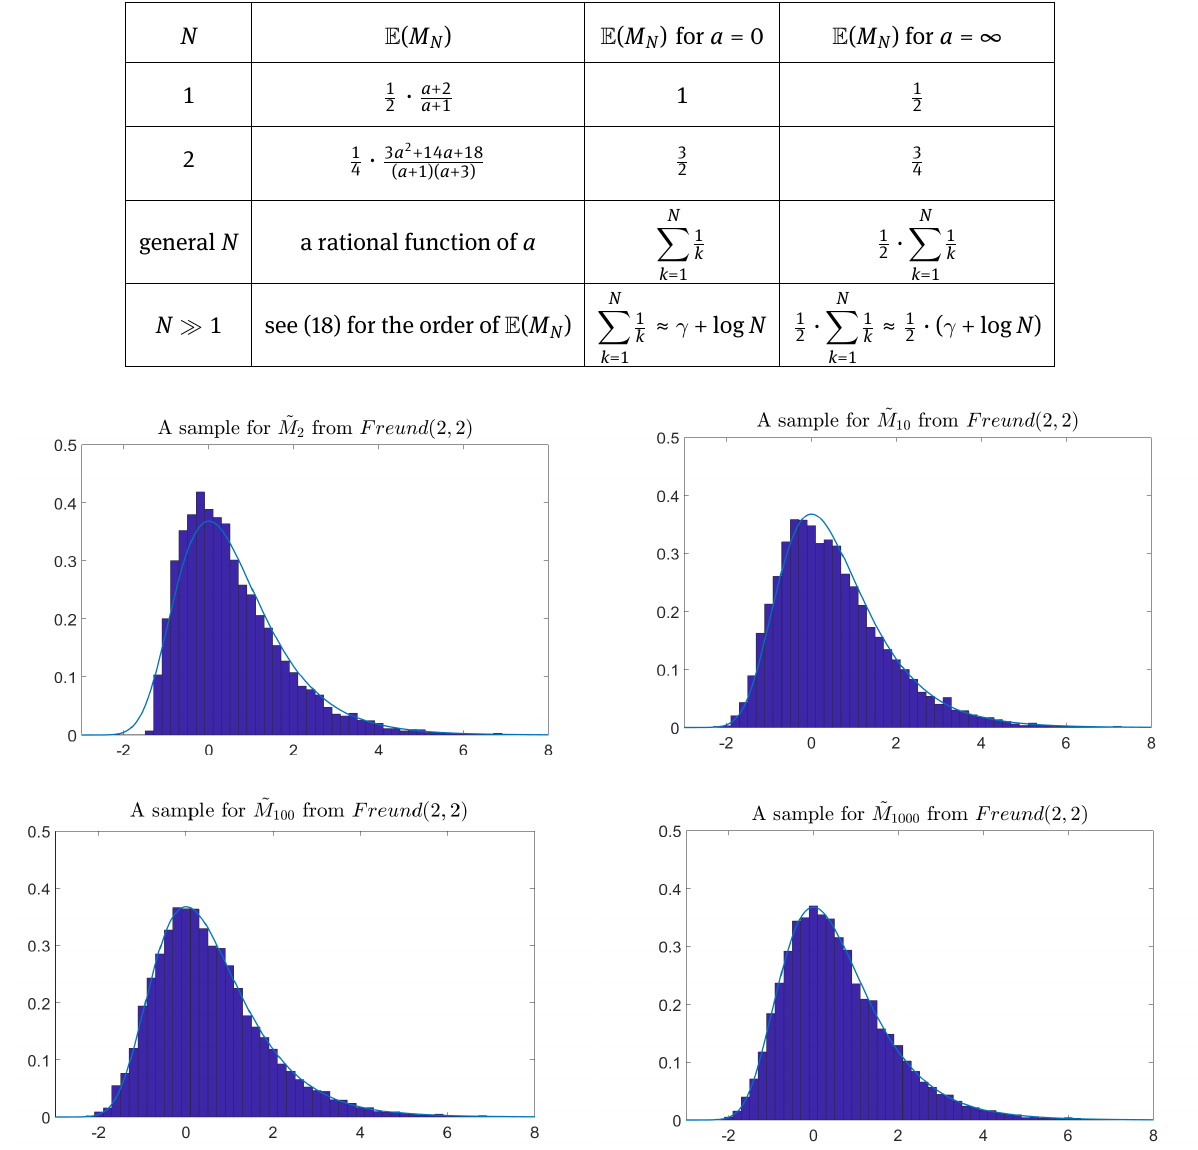
Figure 1: The limiting distribution of the suitably normalized componentwise maximum is the standard Gumbel distribution. The figure illustrates the convergence by samples of size 10000